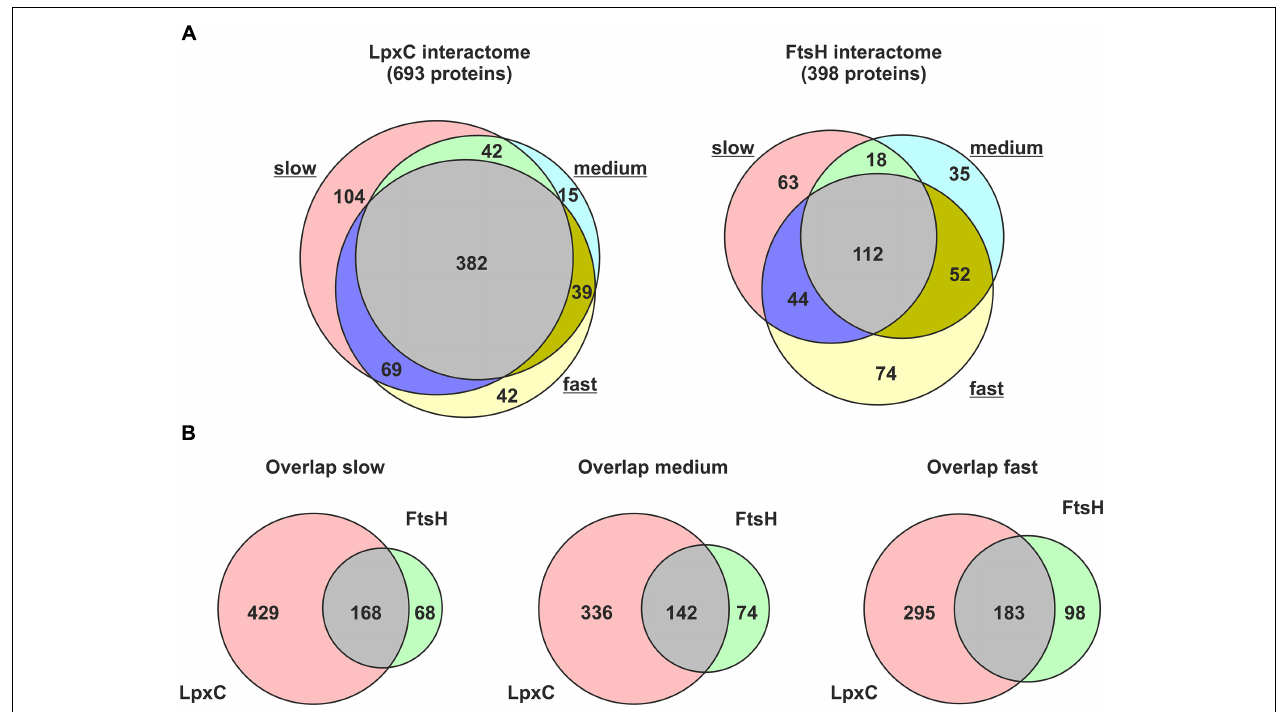
FIGURE 2 | Proteins co-purified with Strep-LpxC or His 6 -MBP-FtsH at different growth-rates (slow, medium, and fast). Overlapping proteins between different growth-rates identified with Strep-LpxC or His 6 -MBP-FtsH are presented in (A) . The overlap between proteins enriched with Strep-LpxC and His 6 -MBP-FtsH at different growth-rates is visualized in (B) . More than 100 proteins overlapping between the LpxC and FtsH interactome networks at slow, medium or fast growth support a close connection between both